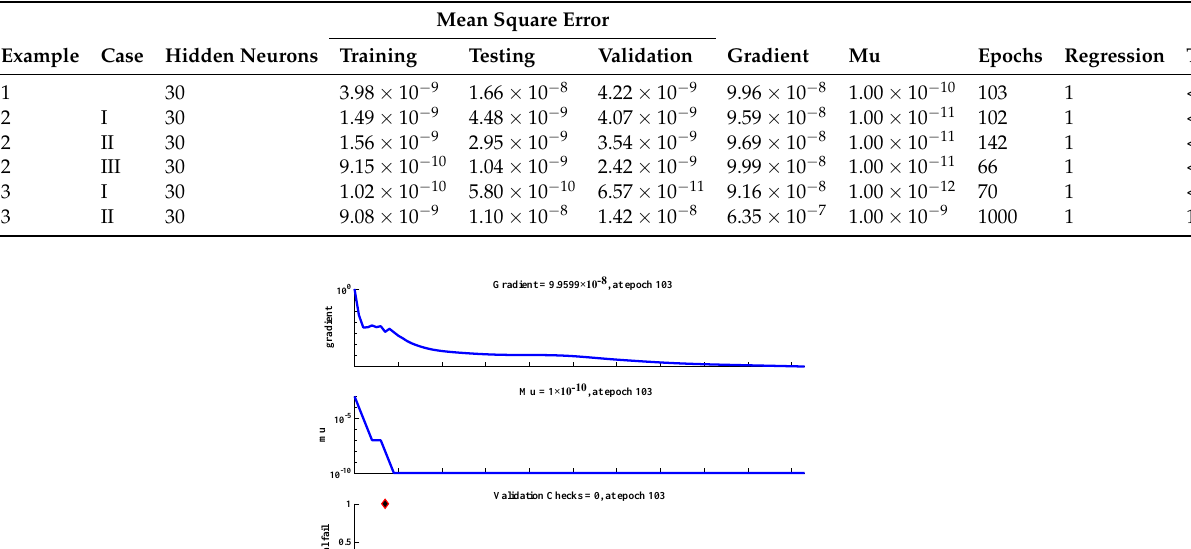
Table 4. Statistical analysis of the performance measures, including MSE, Gradient, mu, number of iterations, and time taken by the system to calculate the results.